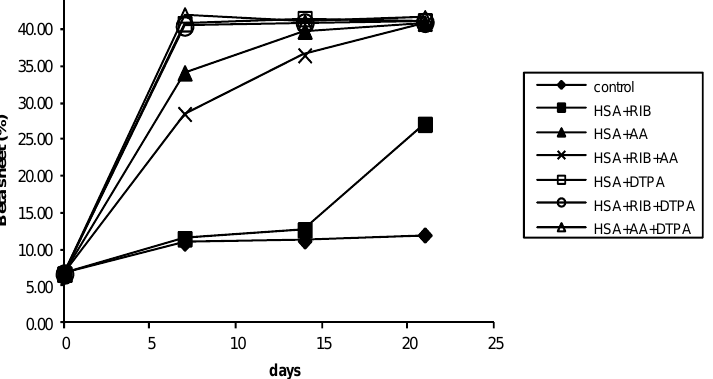
Figure 10. Percentage of beta-sheet conformation in HSA treated with ribose, AA, and DTPA and their combinations, as evaluated by